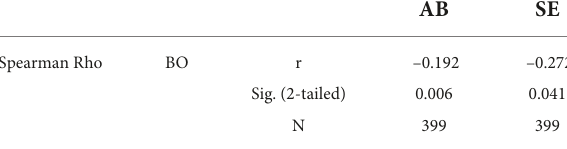
TABLE 3 Correlations between self-efficacy, teacher burnout, and academic